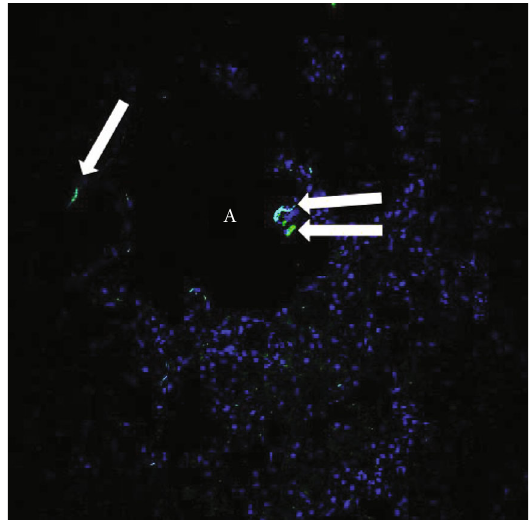
Figure 2: SARS-CoV-2 nucleocapsid protein immuno fl uorescence in lung. Arrows indicate green positive signal. A = alveolar space . Blue = DAPInuclear stain .